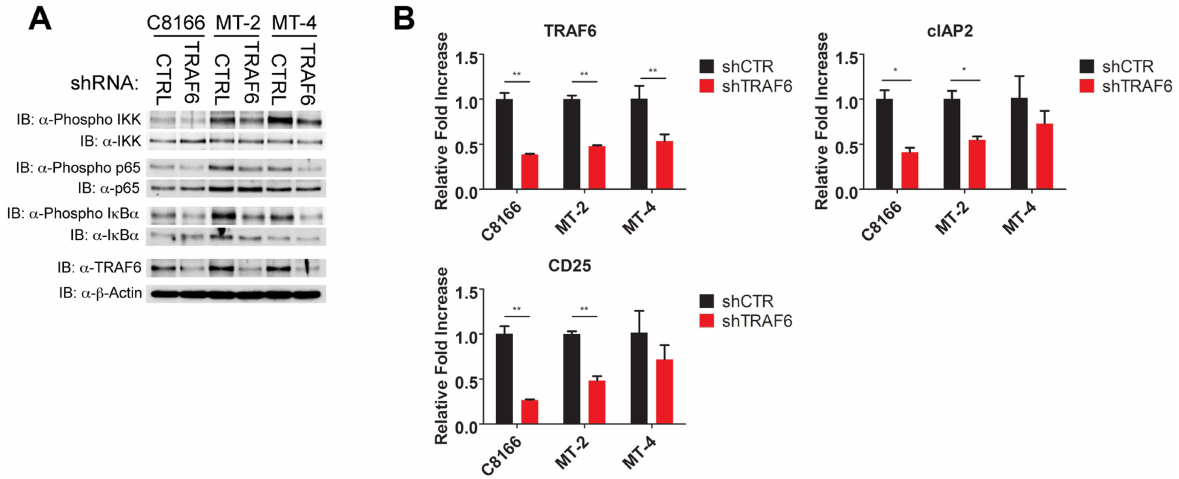
Figure 7. TRAF6 is required for NF- k B activation in HTLV-1 transformed T cells. ( A ) Western blots were performed with the indicated antibodies using whole cell lysates from C8166, MT-2 and MT-4 cells transduced with control or TRAF6 shRNA. ( B ) qRT-PCR of TRAF6, CD25 and cIAP2 mRNAs in C8166, MT-2 and MT-4 cells transduced with lentiviruses expressing control or TRAF6 shRNA.